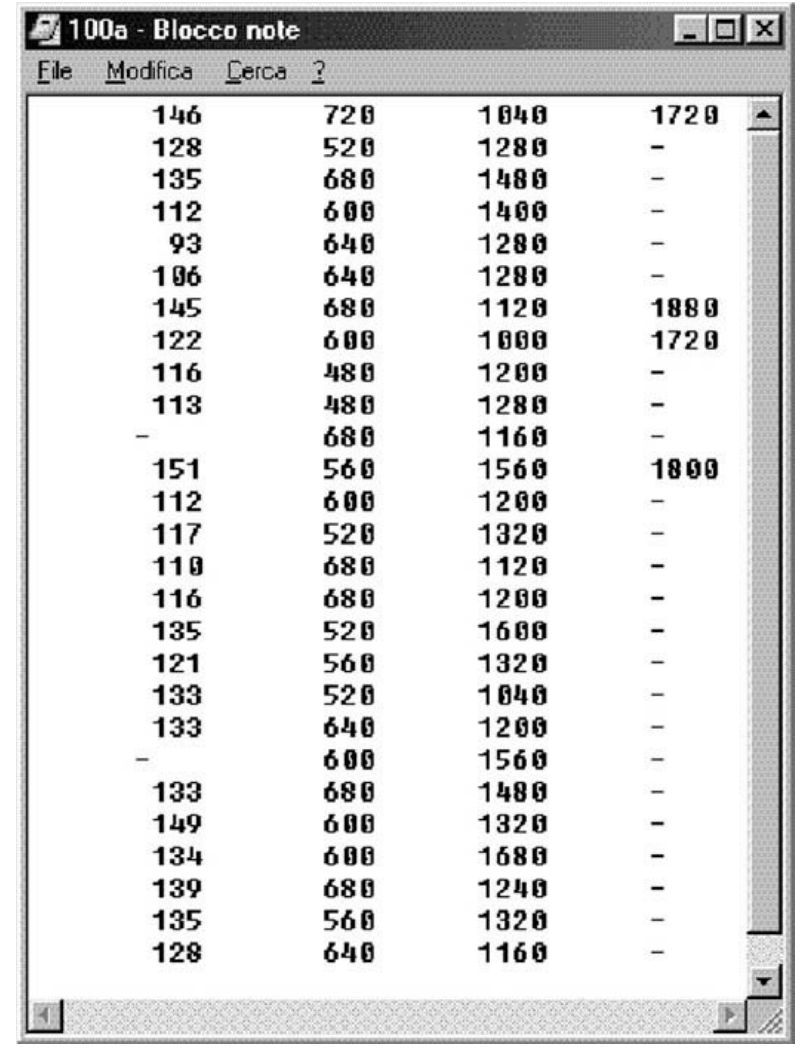
Figura 1 – Matrice dei dati incompleta sulla colonna relativa alla frequenza fondamentale (pochi dati mancanti) e alla formante f (numerosi dati 3